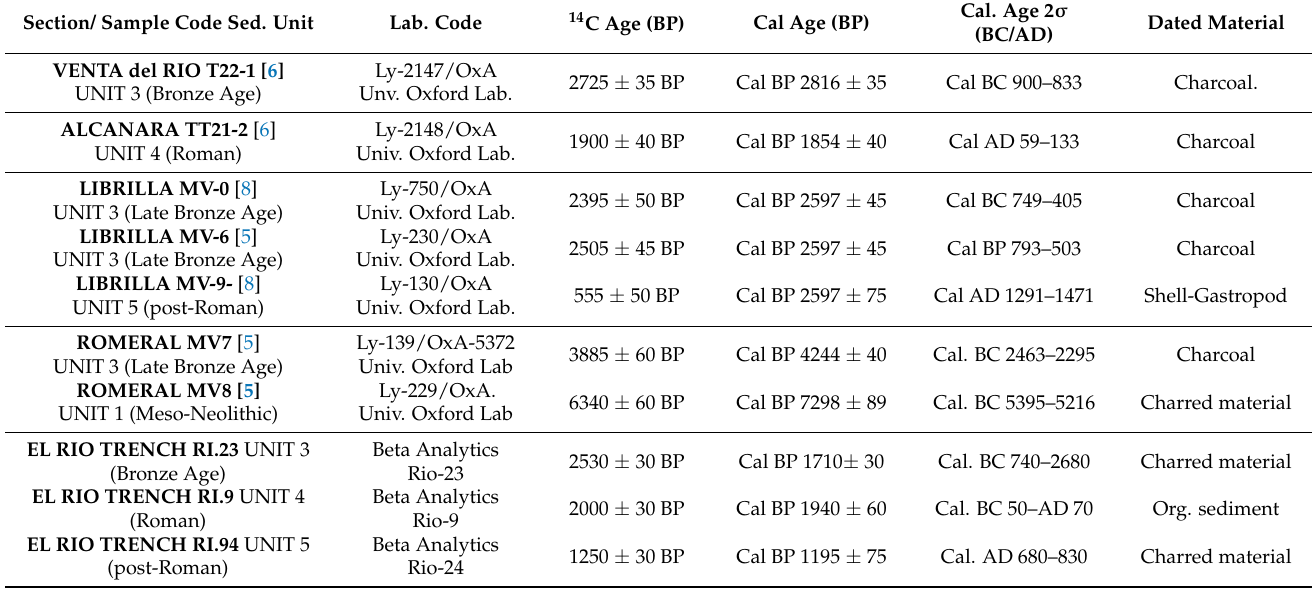
Table 1. Published radiocarbon data for the Holocene filling of the Guadalent í n Depression related with the Roman and Bronze Age sediments and soils discussed in this work obtained from other sections of interest of the zone by Silva et al., 2008 [6]; Calmel- Á vila, 2000 [5]; and Calmel- Á vila, 2002 [8]. The dataset also includes selected radiocarbon data for the paleoseismic trenches excavated in the zone [17] and the pre-Holocene ages obtained by Cuenca and Walker in 1985 (CPW79 and CPW74) reported in the work of Calmel- Á vila, 2000